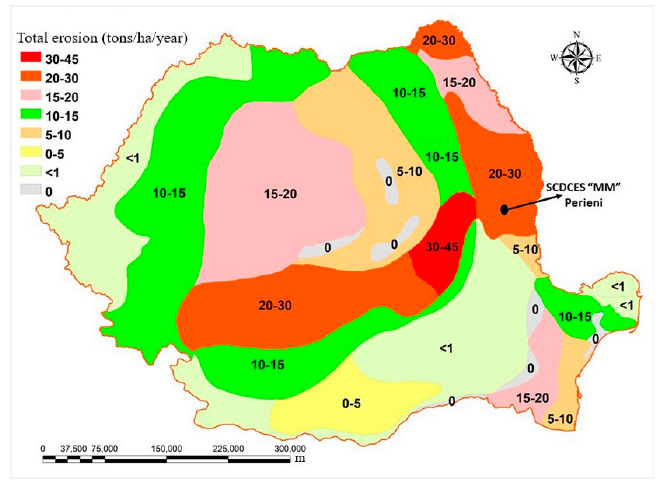
Figure 4. Total erosion on agricultural lands in Romania (tons/-ha/-year). Source: [7].